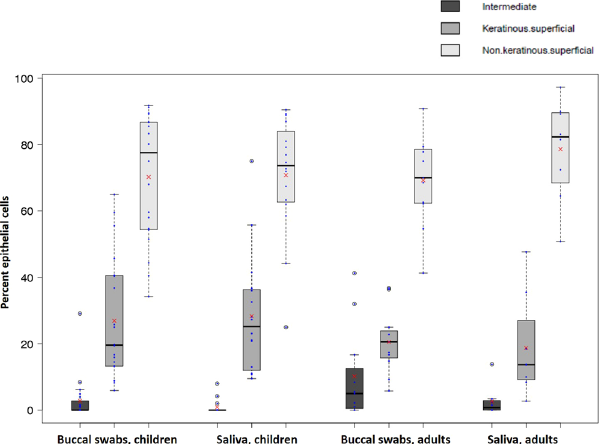
Figure 3. Box and whisker plots of three types of epithelial cells in buccal swabs and saliva from children and adults. Proportions of intermediate, keratinous and non-keratinous superficial cells are shown and indicated with different shades of grey. Means are indicated with red crosses.